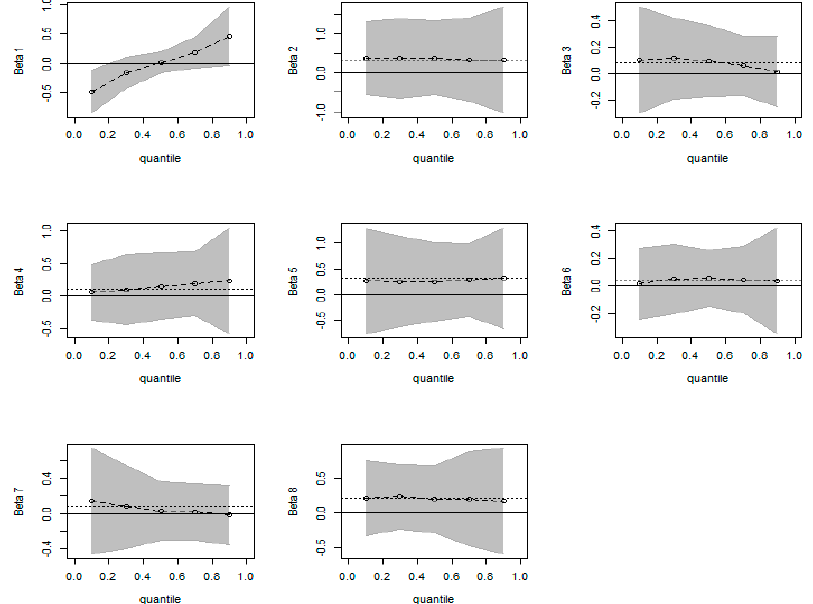
Figure 4. Quantile plots for BQR. The dotted lines represent the OLS estimate. The shaded area shows the adjusted credible intervals as the parameters are estimated. The variables represented by each graph are intercept, INCOME, CD, CO 2 , GFE, DCLI, ODR, and HT, respectively.